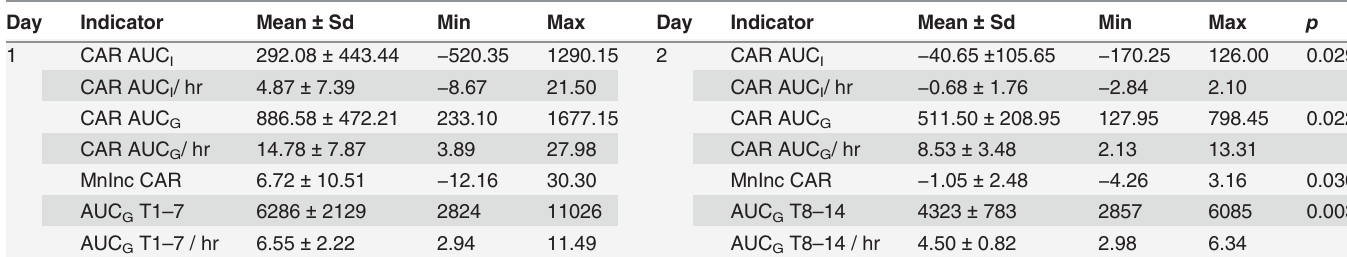
Table 2. Saliva cortisol summary indicators.